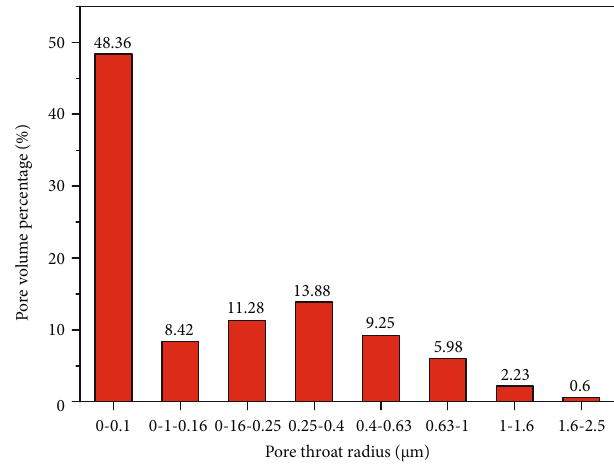
Figure 4: Pore size distribution of six samples by